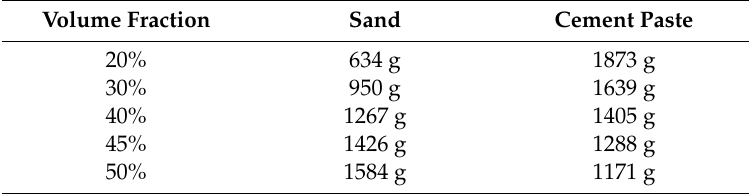
Table 4. Quantities of sand and paste needed to obtain specific volume fractions in mortar samples.